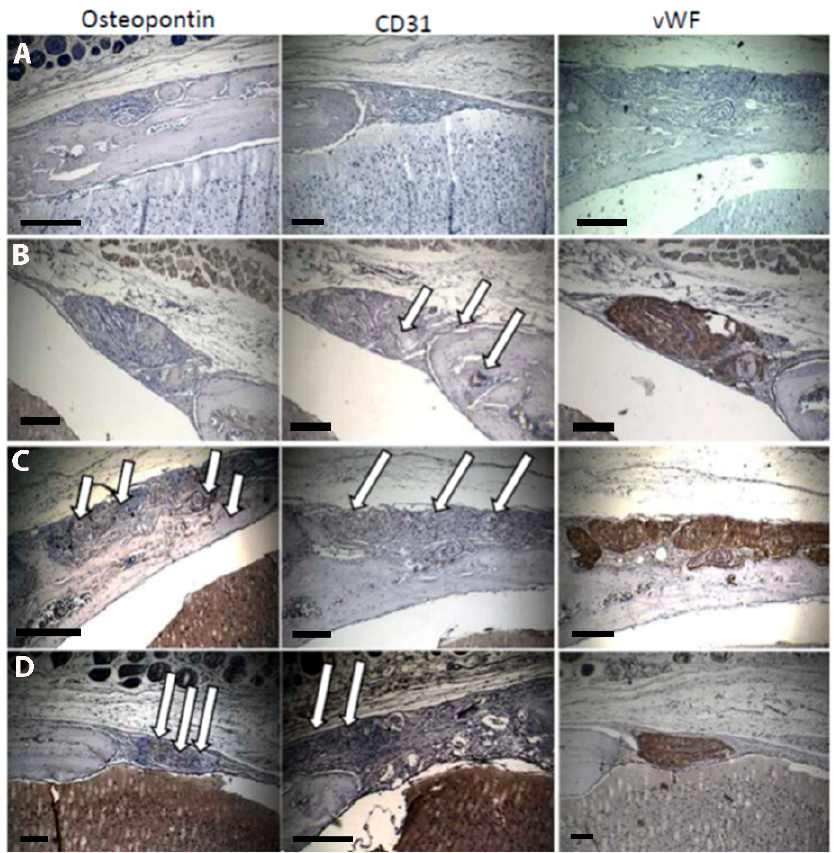
Figure 5. Immuohistological stainings for the endothelial markers von Willebrand factor (vWF) and CD31 and for the osteogenic marker osteopontin. ( A ): negative control; ( B ): hydrogel + co-culture; ( C ): hydrogel + HUVEC; ( D ): hydrogel + SDF-1. White arrows indicate positive stainings. Scale bars represent 300 µm.